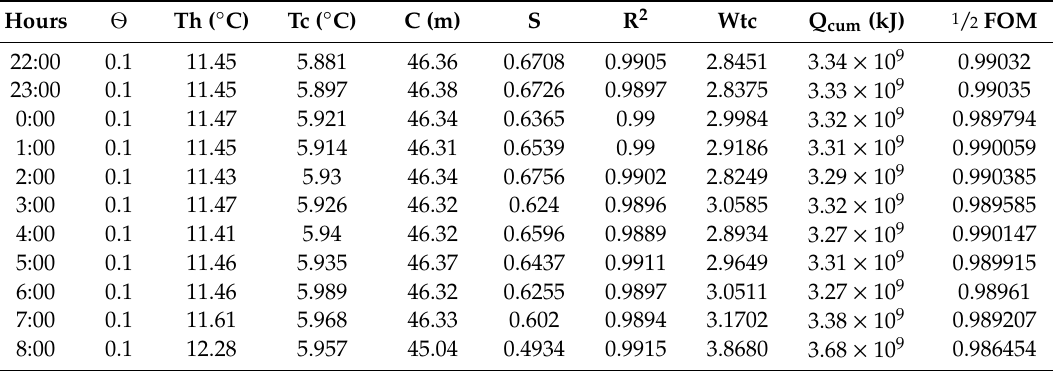
Table A12. 18th–19th October 2019 Curve Fitting and Performance Parameter